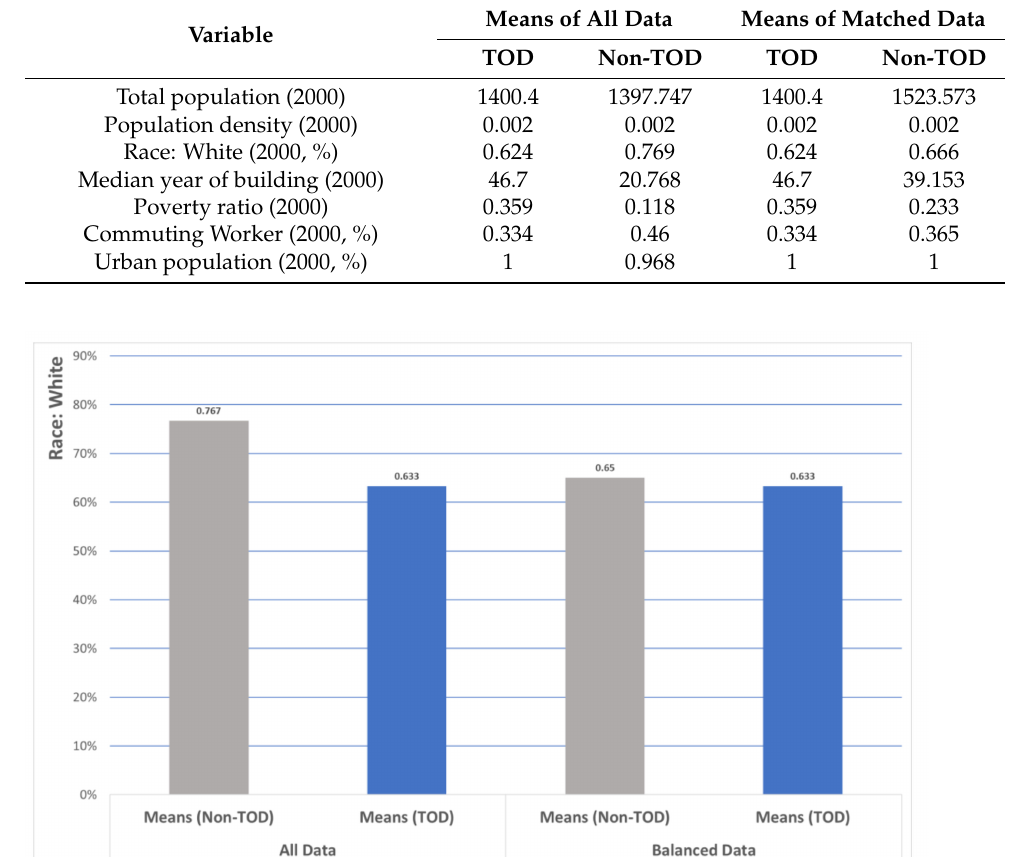
Table 3. Comparison of transit-oriented development (TOD) and Non-TOD neighborhoods.